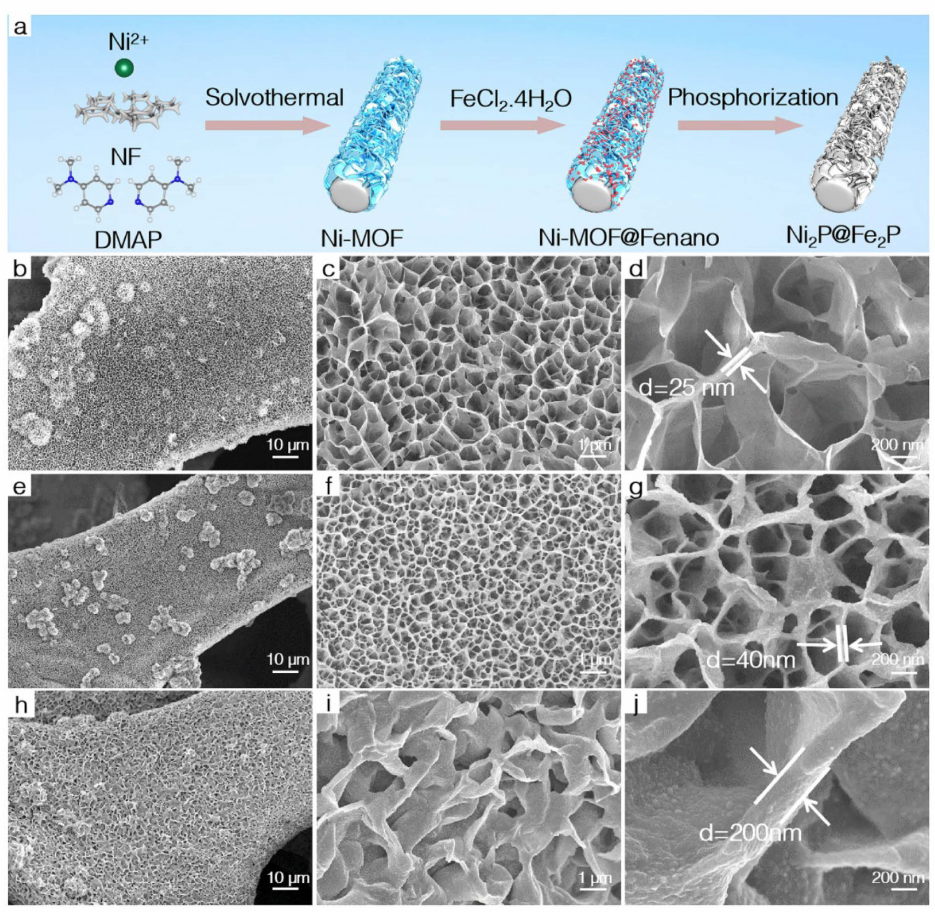
Figure 1. ( a ) Schematic illustration for the synthesis of the Ni 2 P@Fe 2 P. SEM images of Ni-MOF ( b – d ), Ni-MOF@Fenano ( e – g ) and Ni 2 P@Fe 2 P ( h – j